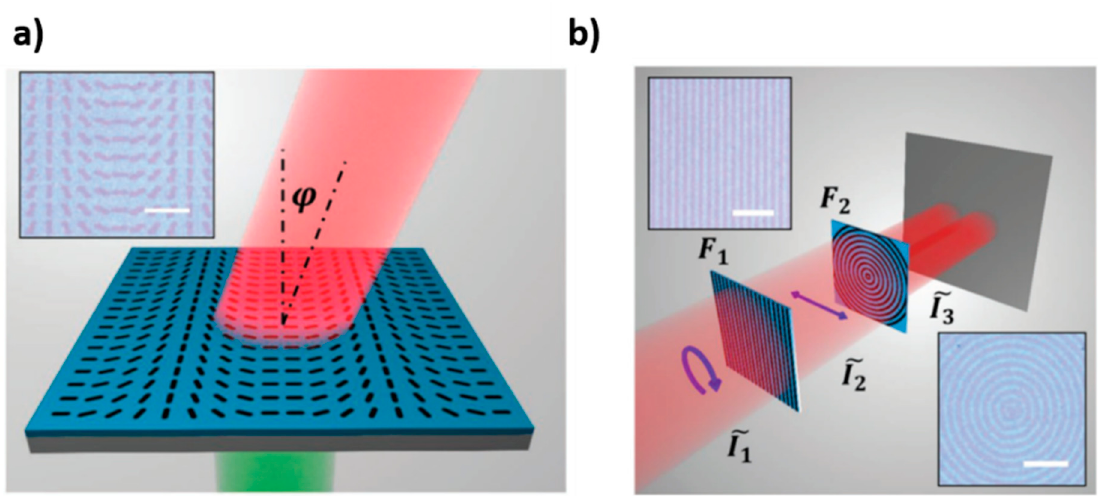
Figure 10. Examples of the employment of VO 2 based metacanvas used for the writing and storage of optical operators and interaction with light. ( a ) beam steering; ( b ) combination of two VO 2 based metacanvas, the first programmed and used as a linear polarizer, the second programmed and used as concentric ring grating. Reproduced from Ref. [48] with permission from Wiley.